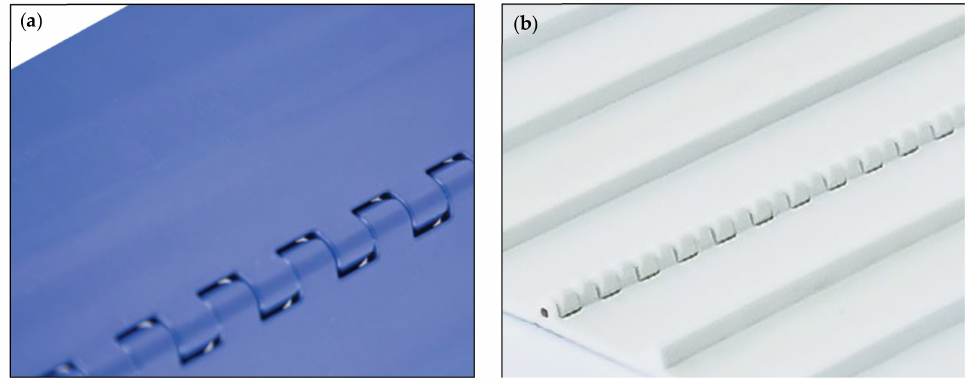
Figure 6. Mechanical Lace: ( a ) fastener in cobalt blue, size 1”; ( b ) fastener in white, size 2” [24].